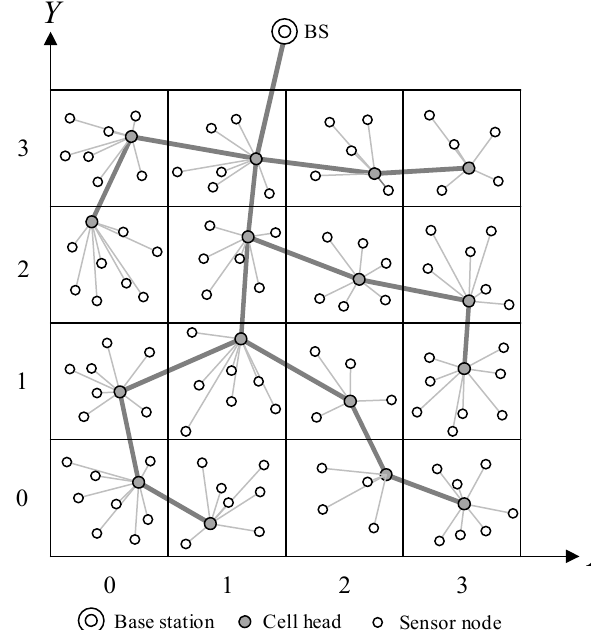
Figure 1. Tree structure of GB-PEDAP.